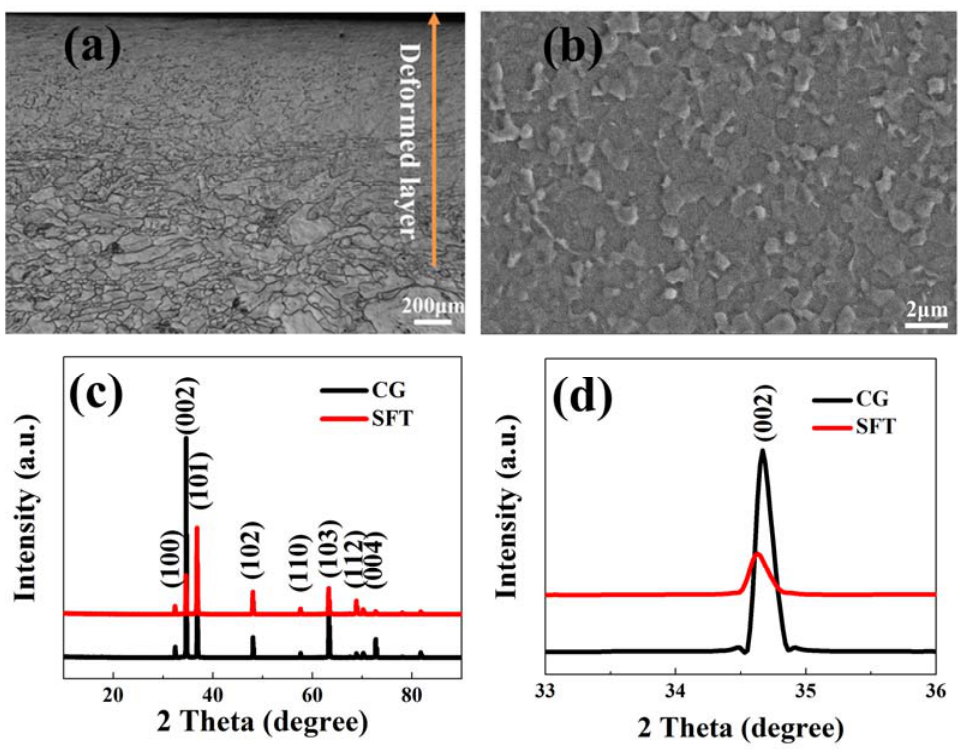
Figure 1. The cross-section ( a ) optical microscopy (OM) and ( b ) SEM picture of sliding friction treatment (SFT) sample; ( c ) XRD patterns of coarse-grained (CG) and SFT sample and ( d ) zoomed figure in the range of 33°–36°.